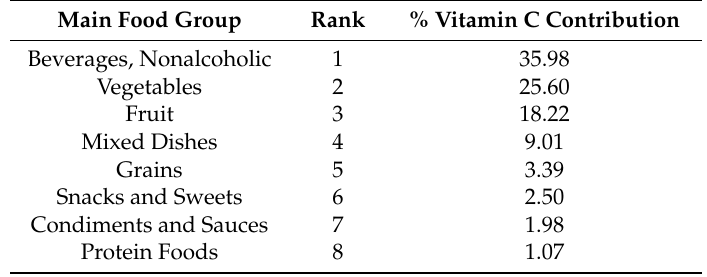
Table 12. Food sources of vitamin C contribution in the total U.S. diet, adults ≥ 51 years old ( n = 4522; gender combined; daily intake data; NHANES 2011–2014; main food groups contributing <1.0% not reported; data are Day 1